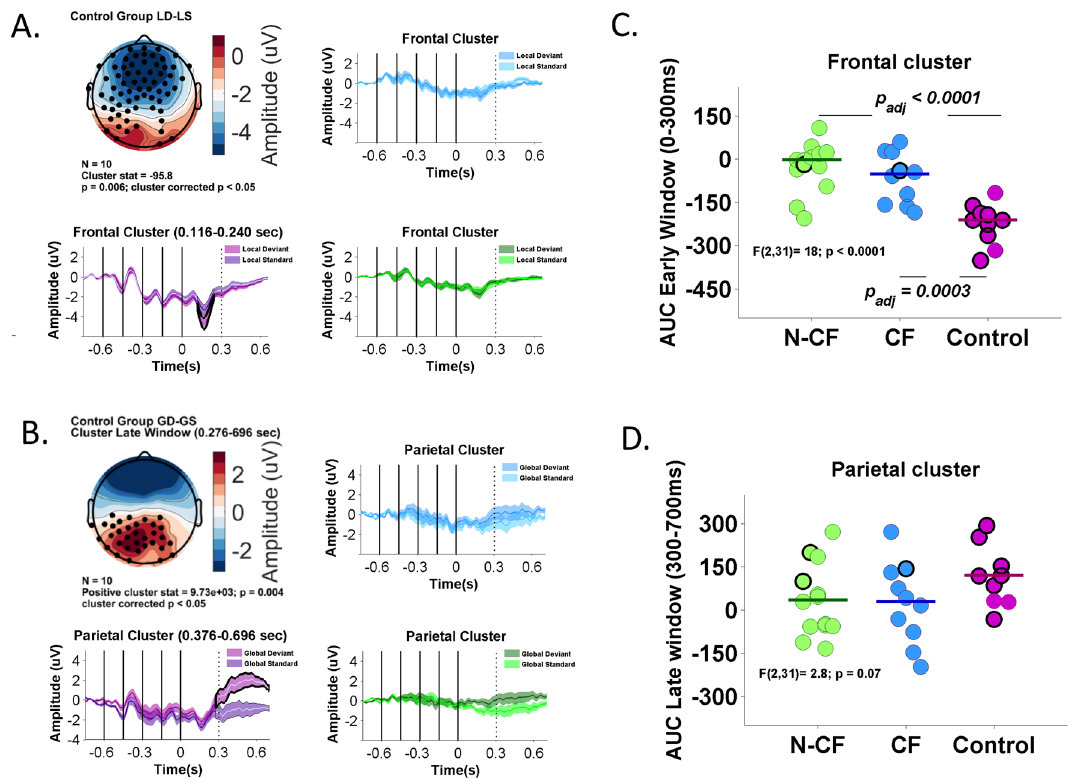
Figure 2. ERP responses at single subject and group level. ( A ) Spatial topography and channels (black dots) indicate where there are significant differences between stimuli related to the local effect (negative cluster stat). Plots shows grand-average ERP time courses for the local deviant and local standard stimuli at this cluster channels. Healthy subject (purple), CF (Blue), N-CF subjects (green). ( B ) Spatial topography and channels (black dots) indicate where there are significant differences between stimuli related to the global effect (positive cluster stat). Plots shows grand-average ERP time courses for the global deviant and global standard stimuli at this cluster channels. ( C ) Individual patient value for the local effect are shown in the scatter plot. Group-wise mean of the area under a curve (AUC) is indicated by horizontal line. circles with black edge shows significant differences at single-subject level. ( D ) Individual patient value for the global